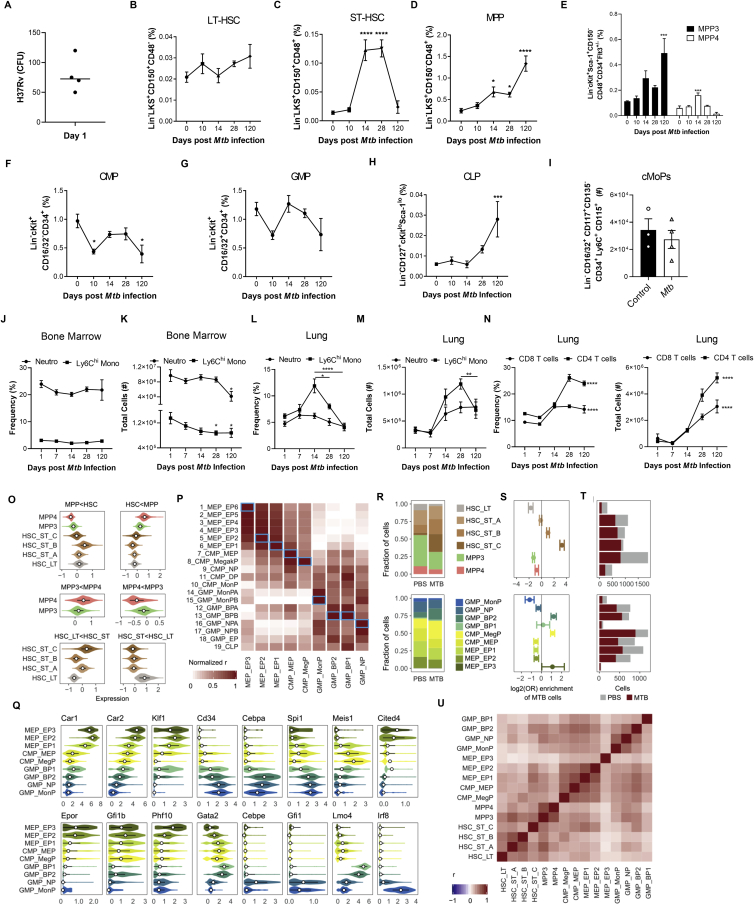
HSC and Progenitor Kinetics following Aerosolized Mtb Infection, Related to Figure 3(A-M) WT mice were infected with aerosolized Mtb. (A) Day 1 lung CFU following aerosol infection. (B-H) Kinetics of the frequencies among BM cells of LT-HSC (B), ST-HSC (C), MPP (D), MPP3/MPP4 (E), CMP (F), GMP (G), CLP (H) in Mtb infected WT mice. (I) Total cell counts of cMoPs in the BM of WT mice at 120 days post-infection. Kinetics of the frequencies and total numbers of neutrophils and Ly6Chi monocytes in the BM (J-K) and lung (L-M) as well as the frequencies and total cell counts of adaptive CD8 and CD4 T cells in the lung (N). (O) Average expression of cell-type markers across clusters. (P) Correlations between genome-wide expression patterns of our myeloid progenitor data and results published by Paul et al. (2015). In each column, Spearman correlations are normalized to cover the range [0-1]. Blue boxes mark the best fit (i.e., candidate identity match) for each of our clusters. (Q) Expression patterns across clusters for some marker genes associated to commitment to the different lineages characterized in this study. (R) Proportion of cells per cluster in both sub-populations (LKS and myeloid progenitors), for cells coming from PBS versus Mtb treated mice. (S) Fisher exact test enrichments (log2 odds ratios) for the fraction of Mtb cells in each cluster. (T) Number of PBS versus Mtb cells in each cluster. (U) Genome wide correlation of Mtb effect sizes (logFC) across clusters. Statistics were (B-H, J-N) One-way ANOVA followed by Tukey’s Multiple Comparisons Test with significance shown compared to day 0 or day 1 post-infection mice for each cell type and Two-tailed Student’s t test (I).